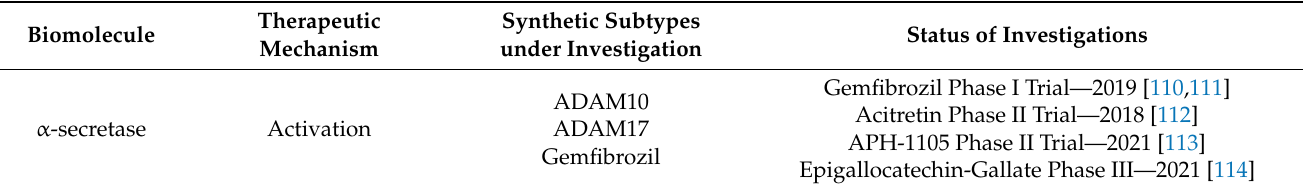
Table 1. Summary of therapeutic modulations of secretase and amylin for